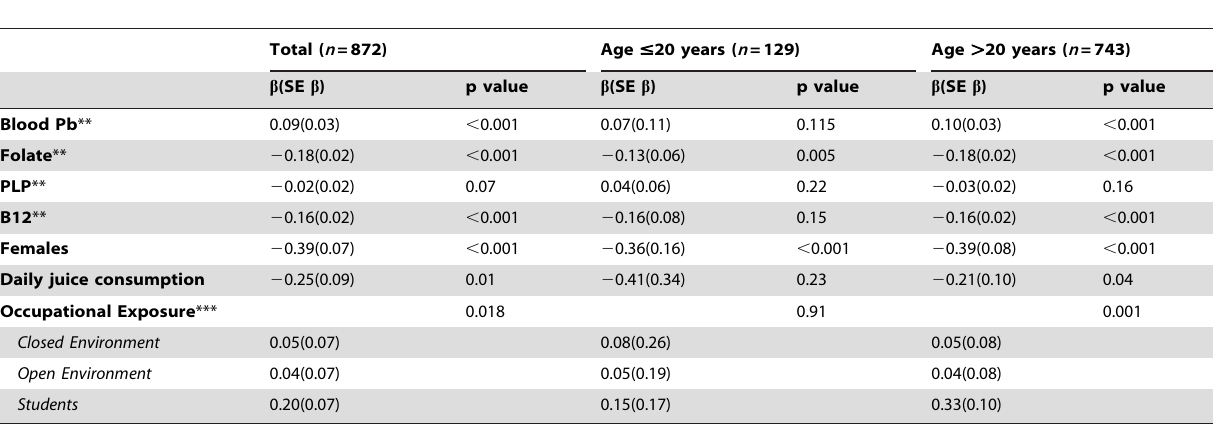
Table 4. Predictors* of log homocysteine levels in Pakistani